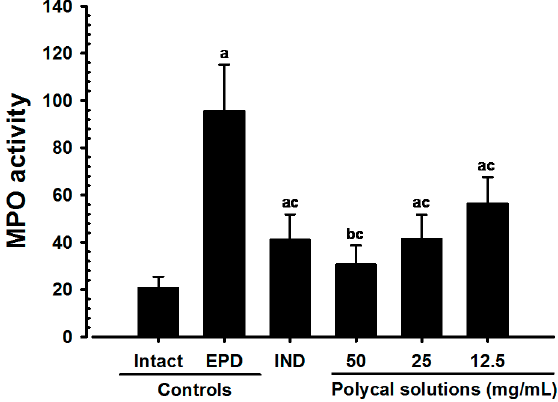
Figure 4. Gingival MPO activities in Intact or EPD rats. Values are expressed mean ± S.D. of eight rats, U/mg tissue. EPD = experimental periodontal diseases induced by ligature placement around the cervix of upper left incisor teeth; Polycal = Polycan and calcium gluconate 2:98 (g/g) mixture, which was topically applied to ligated gingival regions, once a day for 10 days (200 μ L/rats); IND = Indomethacin, which was orally administered at 5 mg/kg dose level, once a day for 10 days. MPO = Myeloperoxidase. a p < 0.01 and b p < 0.05 as compared with Intact control; c p < 0.01 as compared with EPD control.